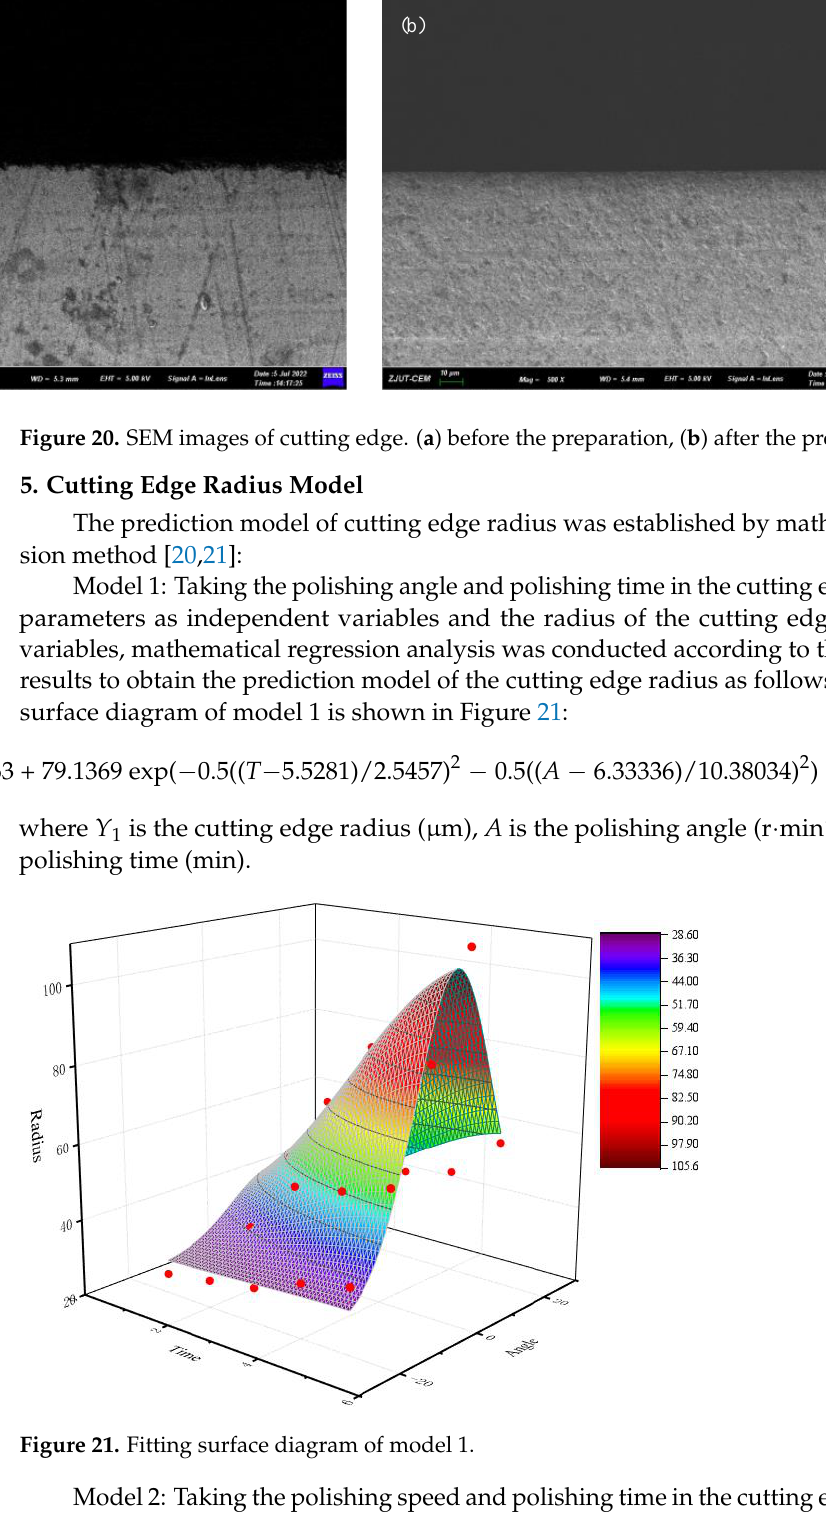
Figure 20. SEM images of cutting edge. ( a ) before the preparation, ( b ) after the preparation .